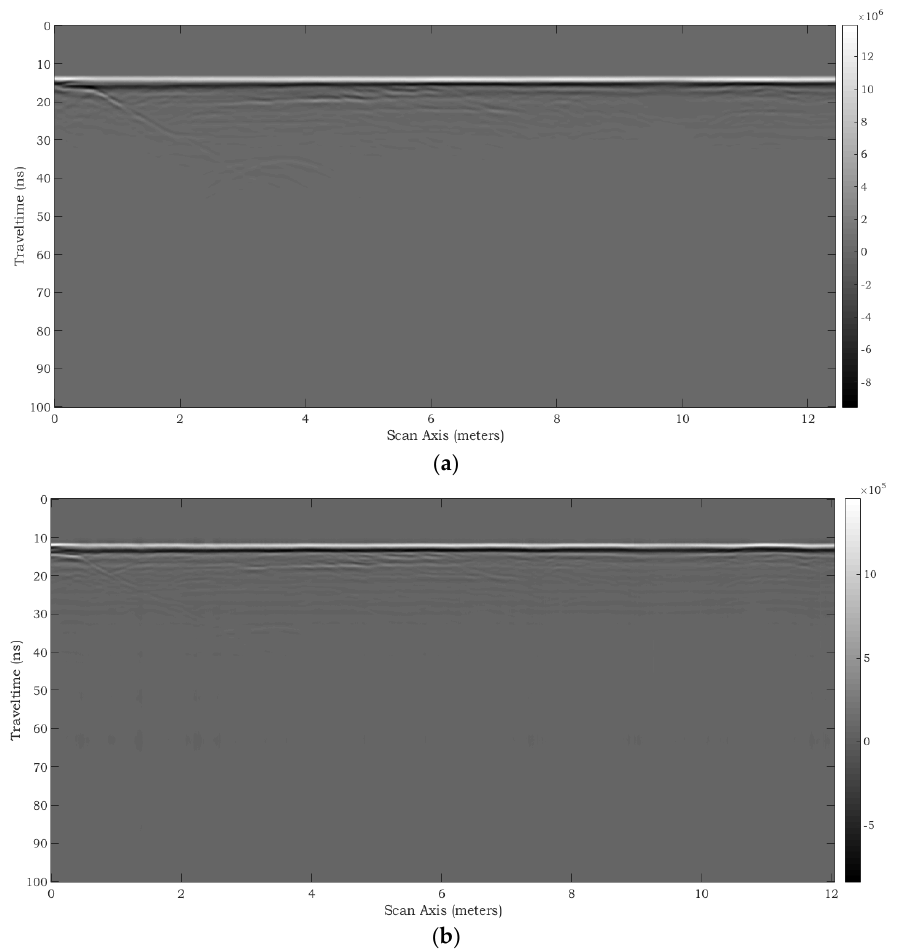
Figure 37. Profiles recorded in the Gneiss 0/20 gravel region by using GPR 1, on acquisition line 1, with last-generation antennas operating at: ( a ) 400 MHz; ( b ) 900 MHz.